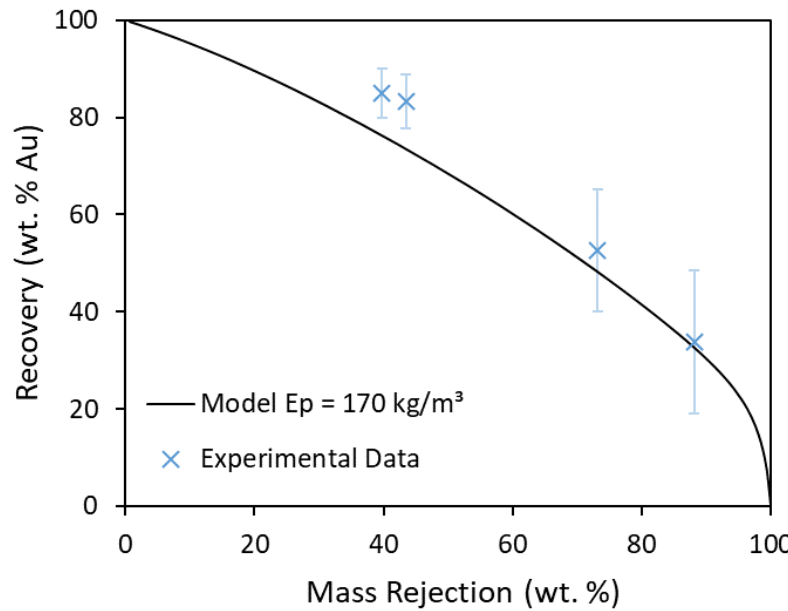
Figure 9. Gold recovery as a function of mass rejection comparing the experimental data [22] with model predictions based on applying the partition surface to the feed density distribution. The partition surface was described by Equation (3), with n = 0.28, S 0 = 300 µm and Ep = 170 kg/m 3 , with the parameter D 0 varied to simulate changes in the controller density set point of the REFLUX TM Classifier.